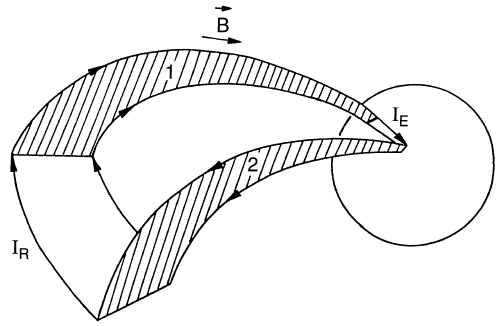
Fig. 15. Sketch of a three-dimensional ionospheric-magnetospheric current system